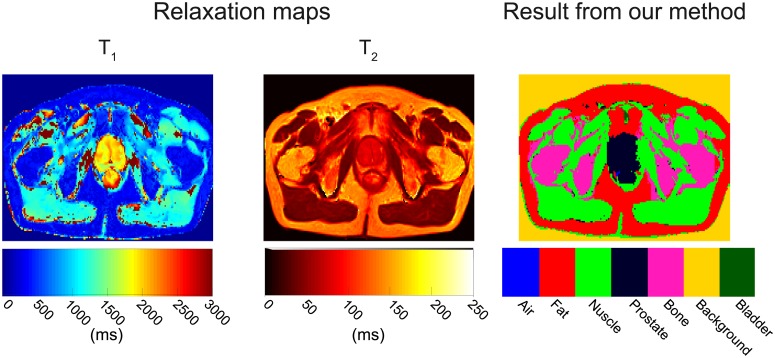
Relaxation maps and classification results of volunteer 3.Even though this volunteer is affected by noncancerous prostatic hyperplasia, the T1 map presents a rather homogeneous range of values in the prostate area (1600–2000 ms). The T1 map also presents a considerable amount of misleading values (≥2000 ms) in the muscle areas. On the T2 map, the muscle areas are well defined (<70ms) and clearly differentiable from the rest of the tissues (prostate, fat, and bone marrow) which seem to merge in a single region. In any case, the SVM accuracy is excellent: prostate = 89.1%, muscle = 98.8%, fat = 100%, and bone marrow = 89.7%. Bladder and air are not present. All features were used to perform the classification.